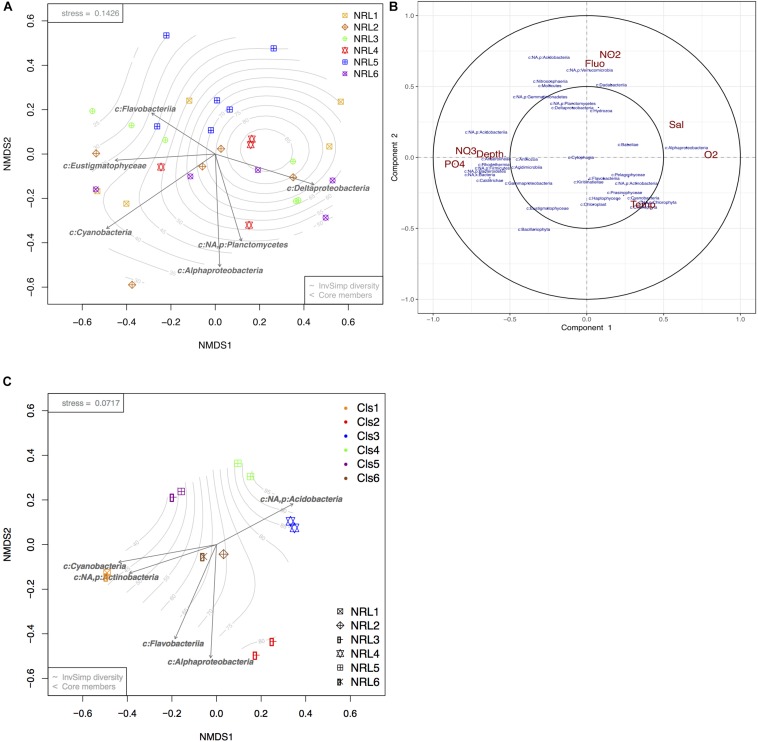
Beta diversity analyses of BoB biofilm communities and microbial response to environmental variables. (A) nMDS ordination plot of square root transformed Bray–Curtis dissimilarity matrix produced from photic zone subsurface biofilm communities (n = 31). (B) Circular correlation plot of BoB biofilm microbial community members (blue) at each site and depth and corresponding environmental variables (red) presented in terms of radial distances and their cosine angles (González et al., 2012; Rohart et al., 2017). (C) nMDS plot of square root transformed Bray–Curtis dissimilarity matrix produced from 12 selected biofilms. Arrows present core phylotypes (significance > 0.05) that best explain the biotic structure with length representing the strength of the correlation. Gradient represents sample diversity based on Inverse Simpson values.